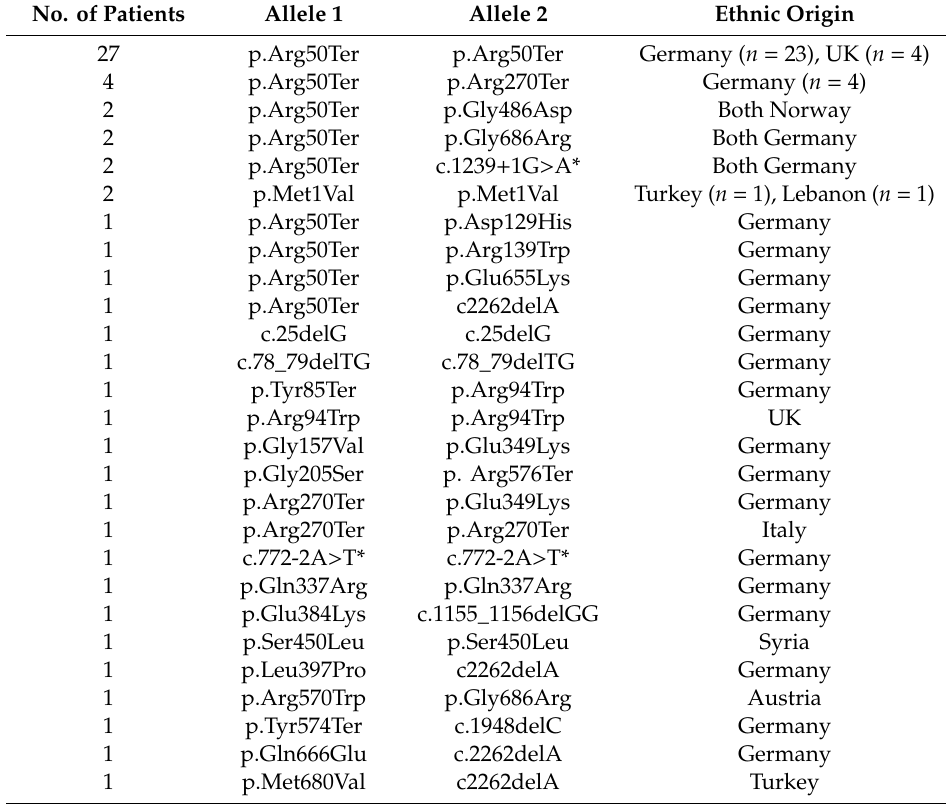
Table 3. Genotype and ethnic origin characterization of patients (splice-site mutations are marked by